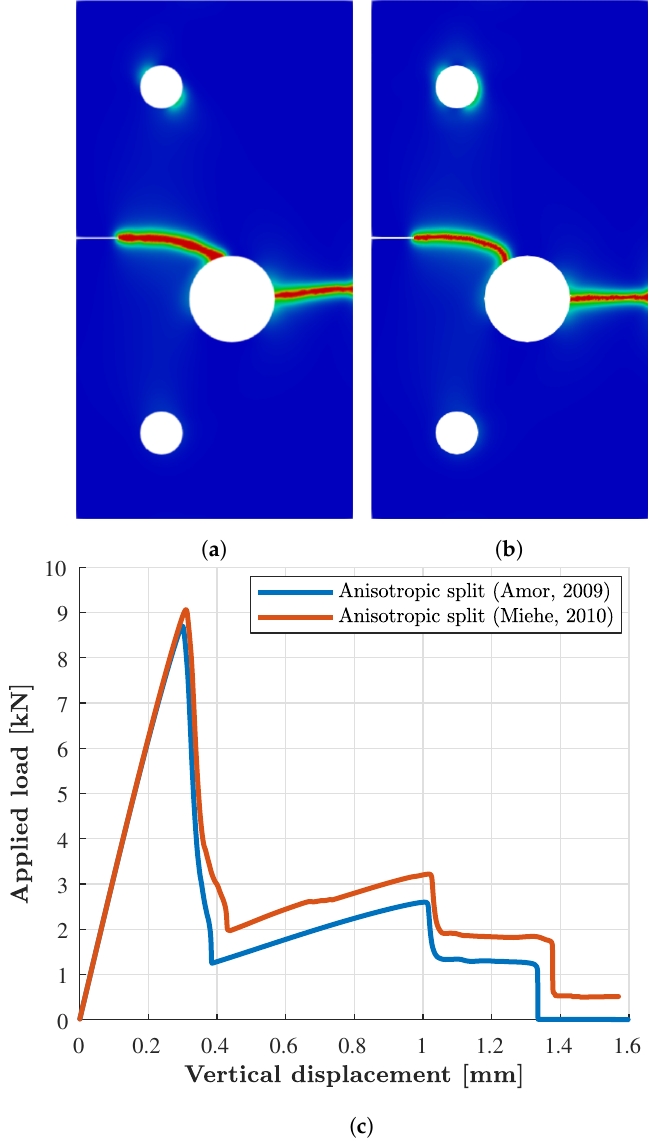
Figure 30. NPwH comparison between anisotropic phase field models with strain energy splits proposed in [232,264]. ( a ) Crack path from analysis implementing the anisotropic split proposed in [232]; ( b ) Crack path from analysis implementing the anisotropic split proposed [264]; ( c ) Force-displacement response comparison between the anisotropic phase field